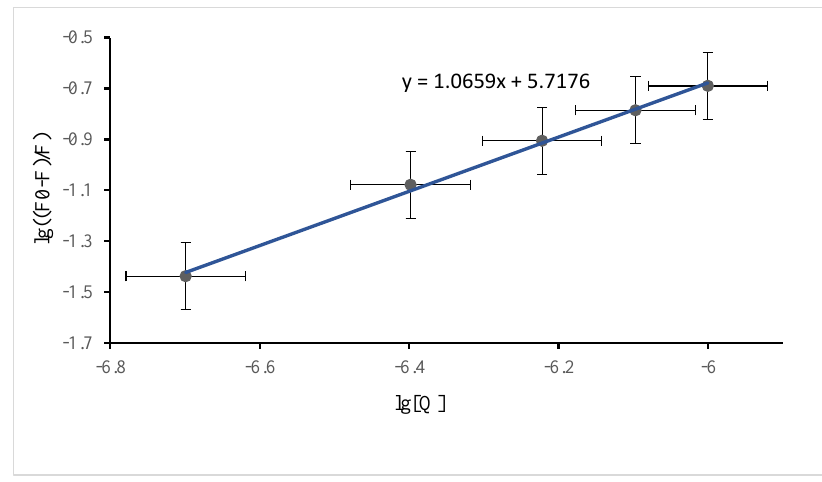
Figure 3. Double logarithm quenching plot for syn − Dechlorane plus and sheep serum albumin.